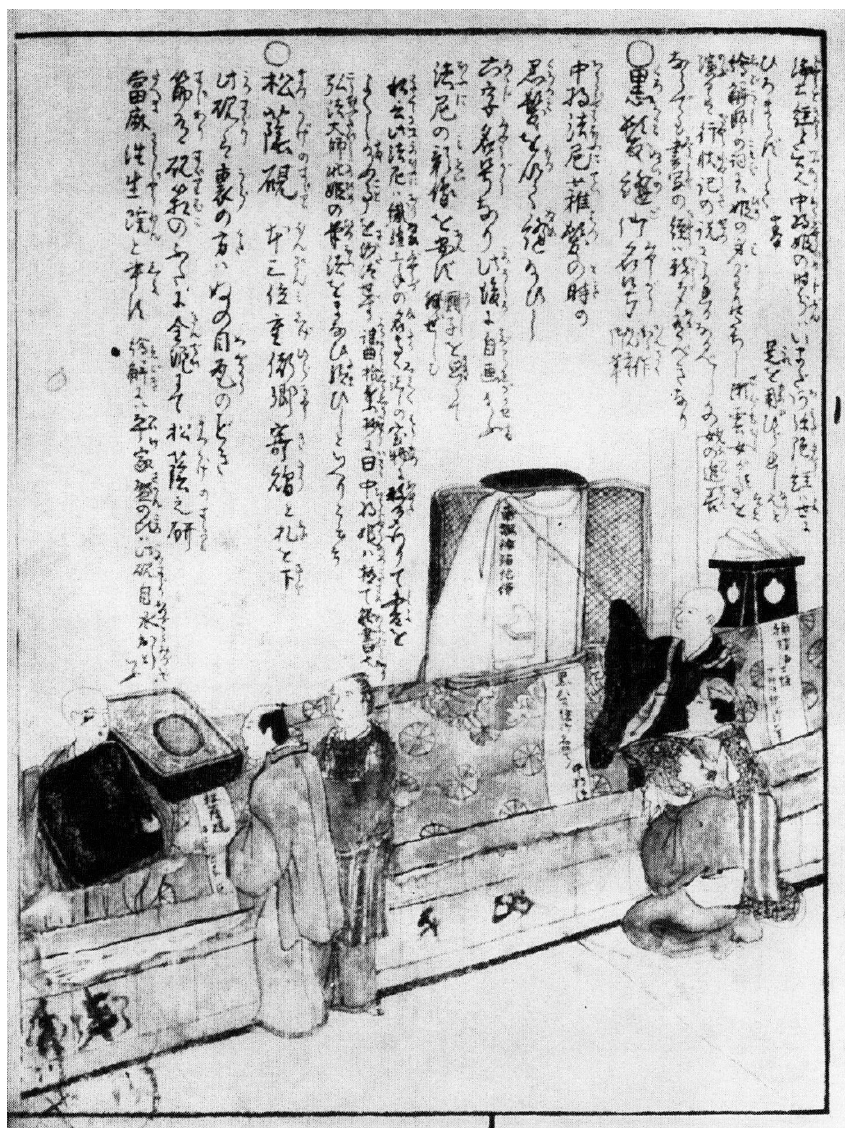
Figure 6. Chūjōhime’s hair embroidery on display. From Saru-an Takariki Tanenobu (1756-1831), Figure 6. Ch¯uj¯ohime’s hair embroidery on display. From Saru-an Takariki Tanenobu (1756–1831), Kaichō danwa, 1829. Source: Hayashi Masahiko, Edo o itoite jōdo e mairan: Bukkyō bungakuron, Kaich¯o danwa, 1829. Source: Hayashi Masahiko, Edo o itoite j¯odo e mairan: Bukky¯o bungakuron, (Tokyo: Meicho Shuppan, 1995, 315). (Tokyo: Meicho Shuppan, 1995,